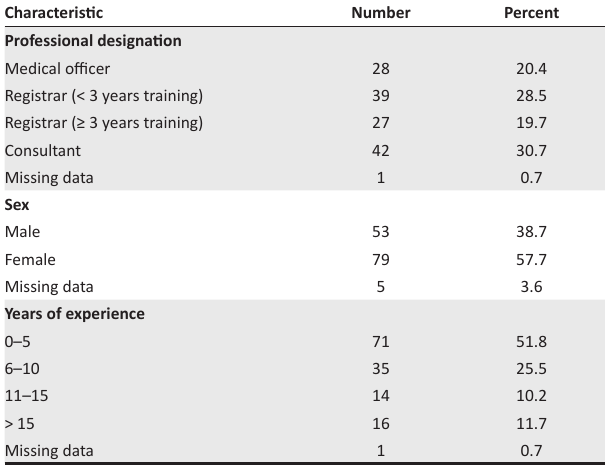
TABLE 1: Characteristics of